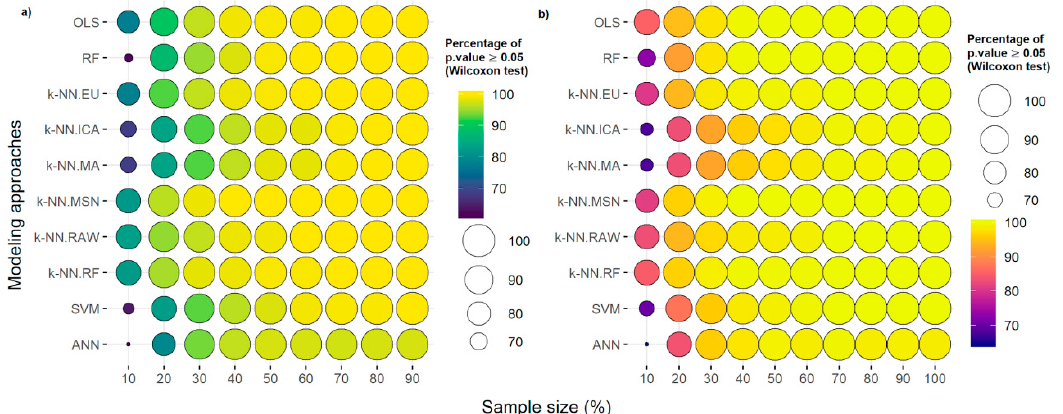
Figure 7. Percentage of p -value > 0.05 for the Wilcoxon test when compared with ( a ) the volume prediction derived from the reduced sample size with the full dataset, and when compared with ( b ) the reference volume.